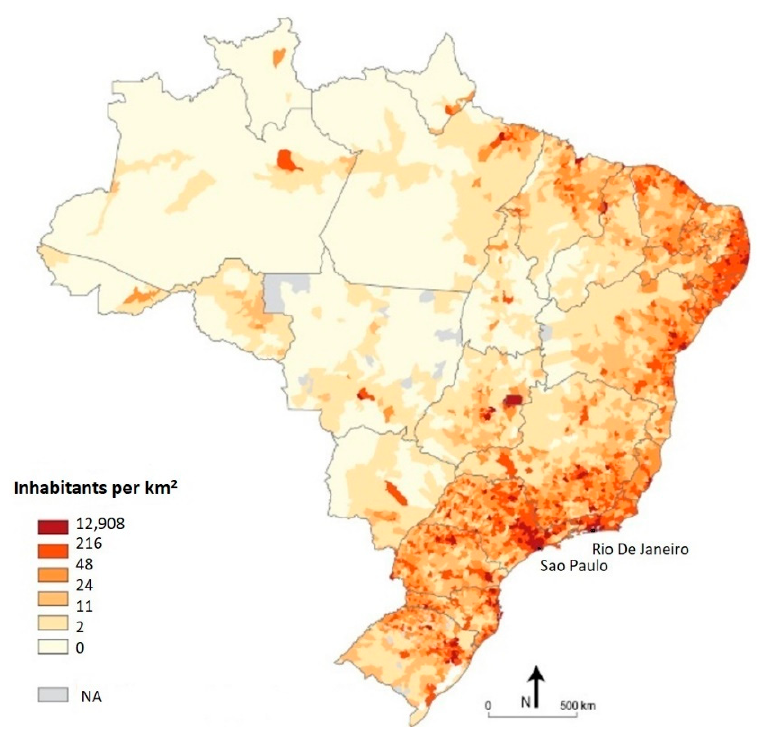
Figure 7. Map of Brazil’s population density.